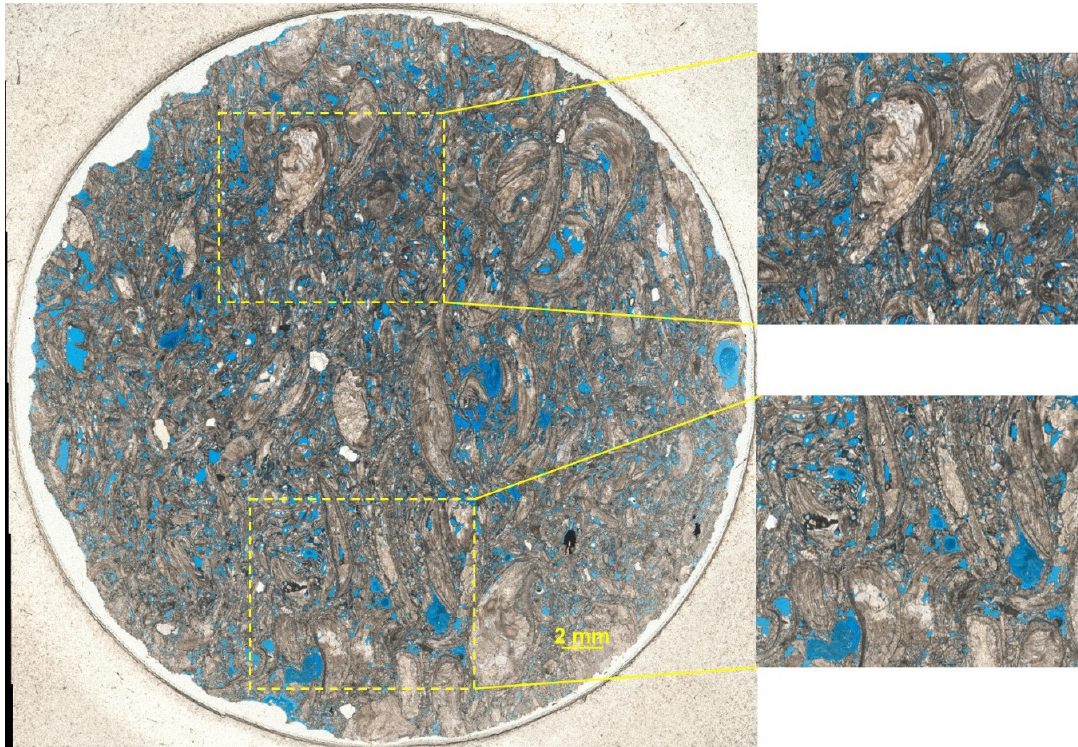
Figure 1. Thin section of coquina sample classified as a grainstone. With the zoomed images on the right, it is possible to observe the different pore types and the heterogeneity of the rock constituents. Magnification of 2.5 times.